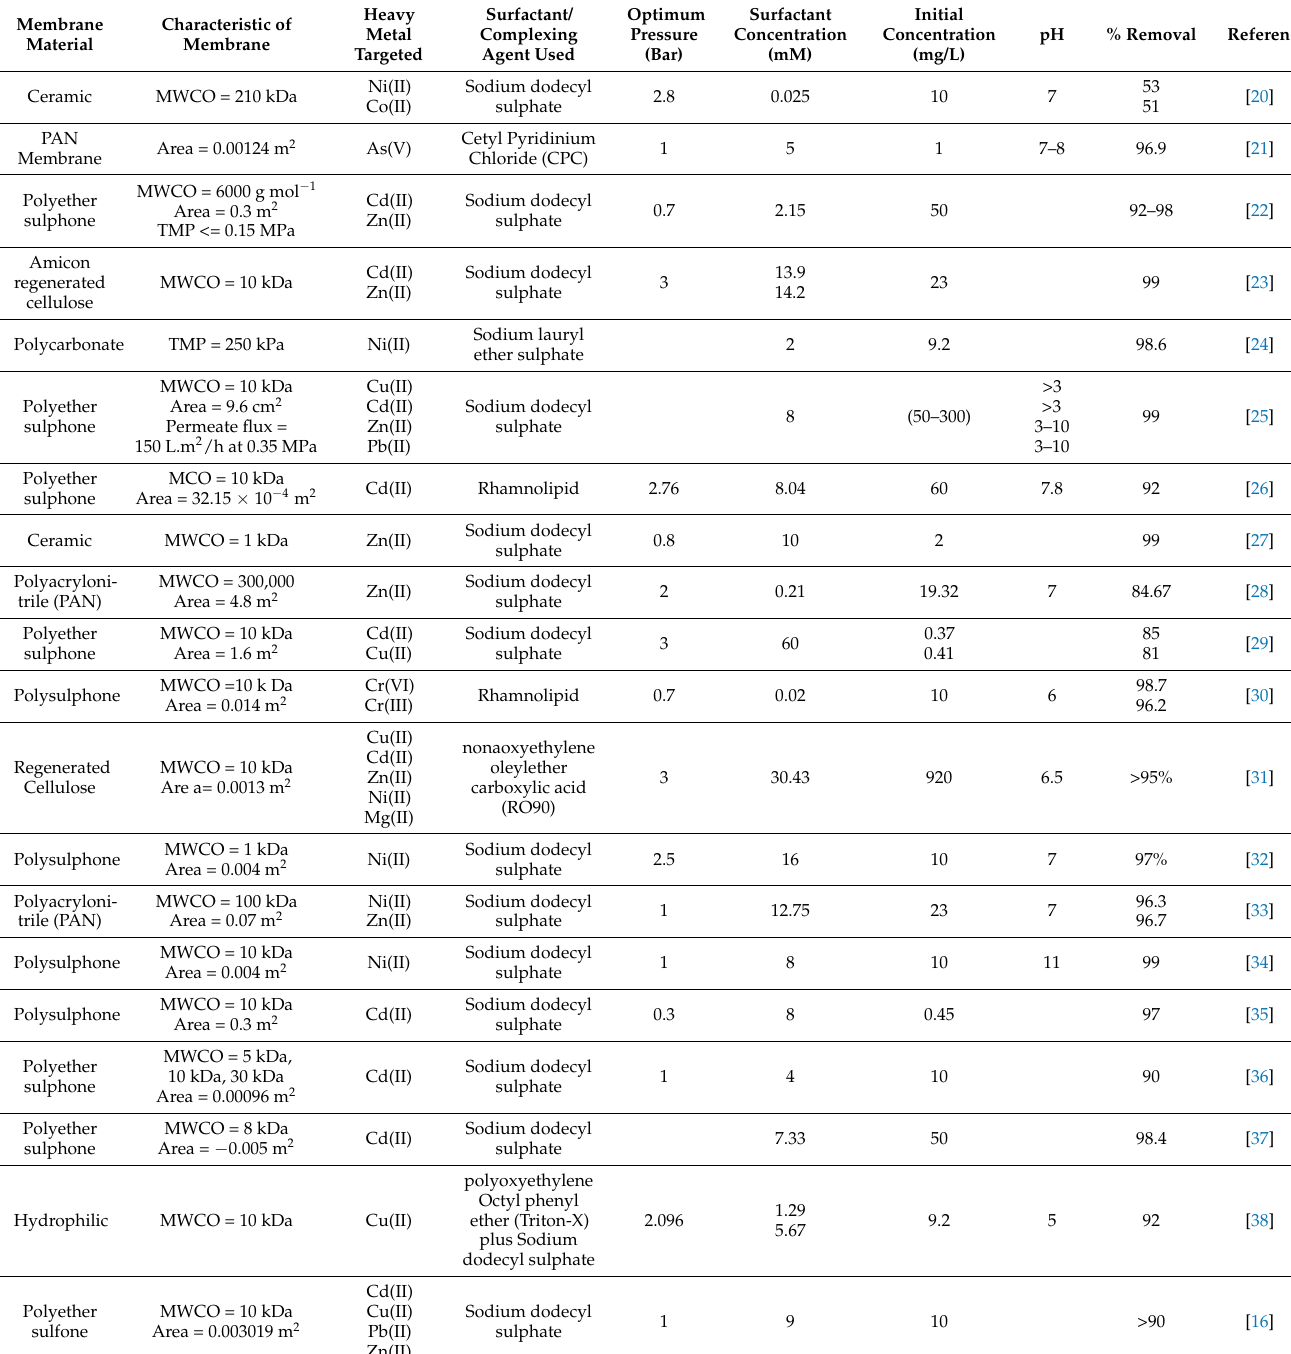
Table 1. Various membranes in wastewater